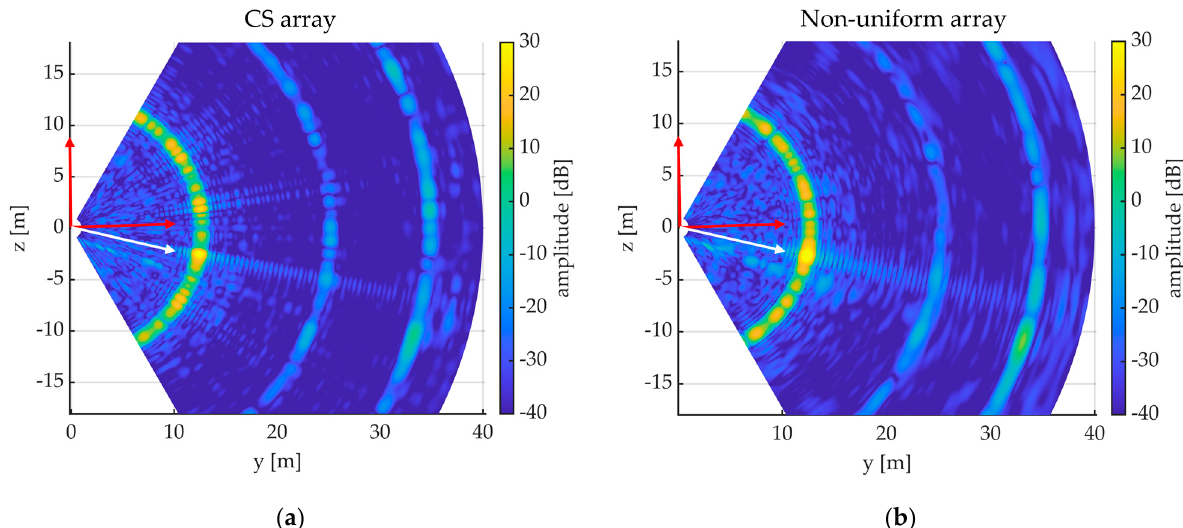
Figure 8. Radar images acquired with the CS array ( a ) and with the non-uniform array ( b ) focused